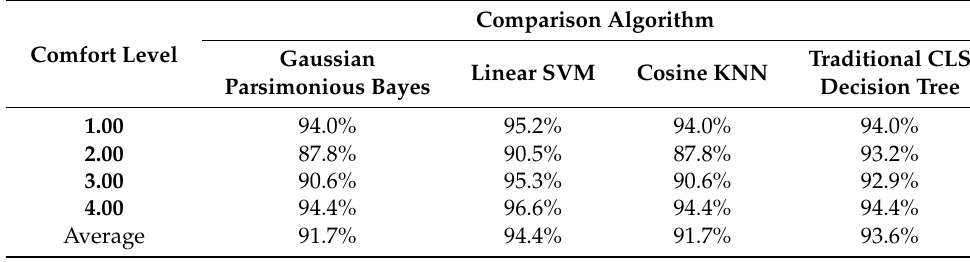
Table 13. Classification accuracy of each comparison